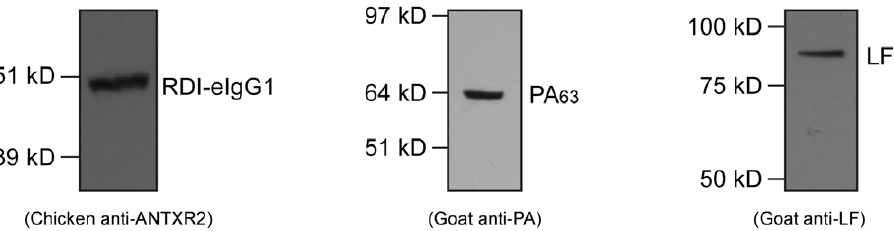
Figure 5. Association of PA 63 and LF with RDI-eIgG1 during circulation invivo . Rats were injected through jugular vein cannulas with a total volume of 500 m l containing 40 m g PA, 12 m g LF, 122 m g of RDI-eIgG1 in PBS vehicle per rat. This corresponds to a 5:1 molar ratio of the VWA/I domain:PA. Serum was prepared from blood collected 15 hours after injection and protein G sepharose was used to precipitate RDI-eIgG1 and associated proteins from the rat serum. Samples were separated on a SDS-containing 4–12% polyacrylamide gel and analyzed by immunoblotting for the presence of RDI-eIgG1, PA, or LF.